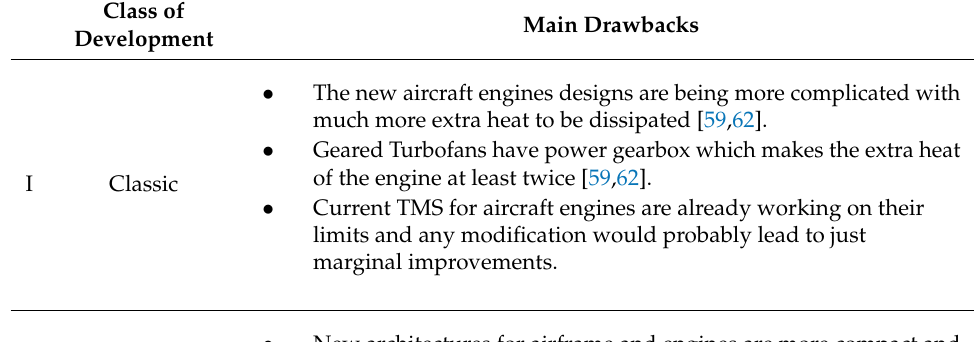
Table 2. Drawbacks of the classes of TMS development for the future